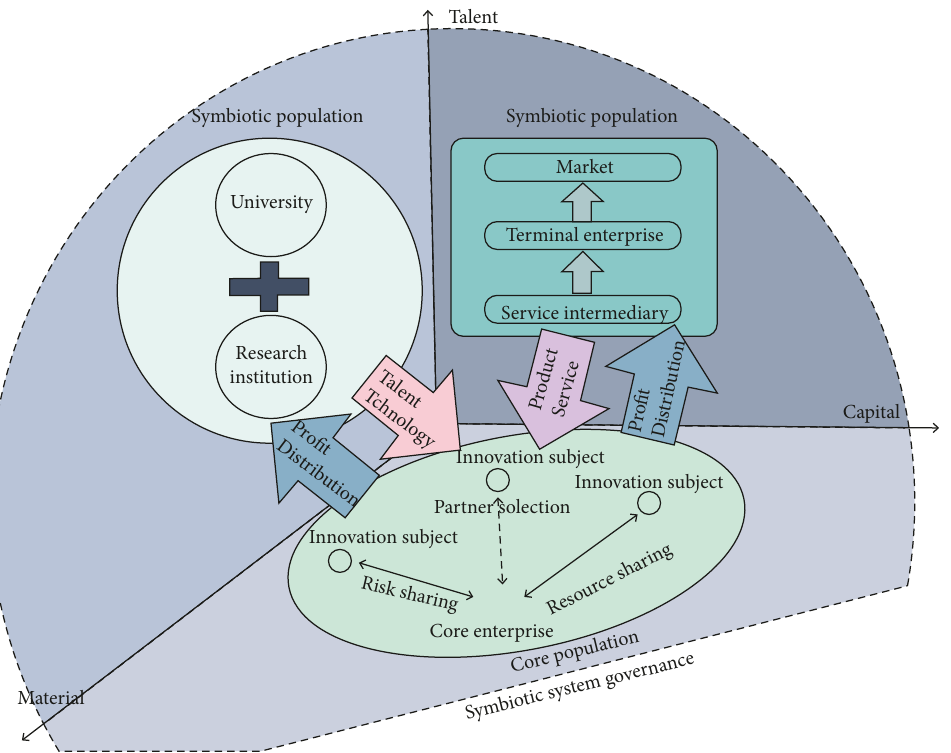
Figure 1: Symbiotic system of innovation ecosystem in high-tech